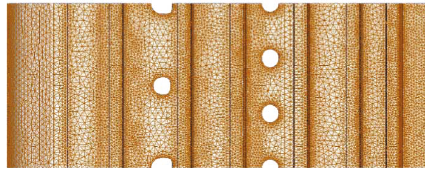
Figure 10: Grid on the fl ame